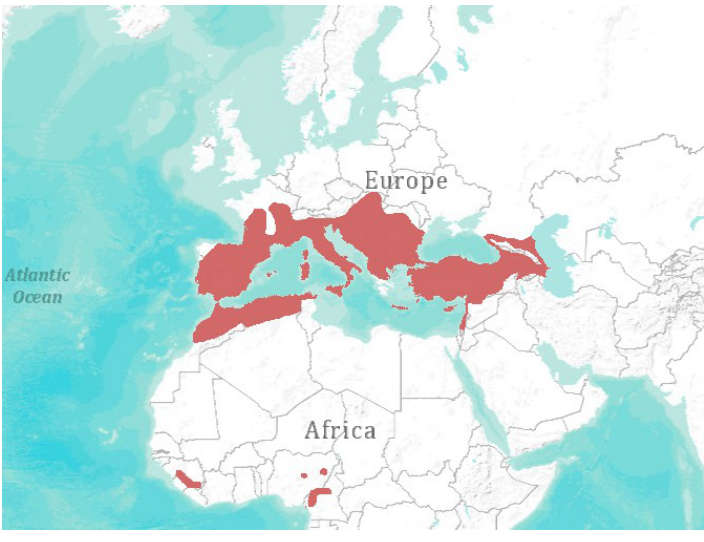
Figure 2. Geographical distribution of Miniopterus schreibersii [1]. Visualization: ArcGIS Explorer.1:50.000.000 [71] (Map sources: Esri, U.S. Geological Survey (USGS), National Oceanic and Atmospheric Administration (NOAA). Sources: Esri, DeLorme, USGS, NPS. Spatial data source: International Union for Conservation of Nature (IUCN))